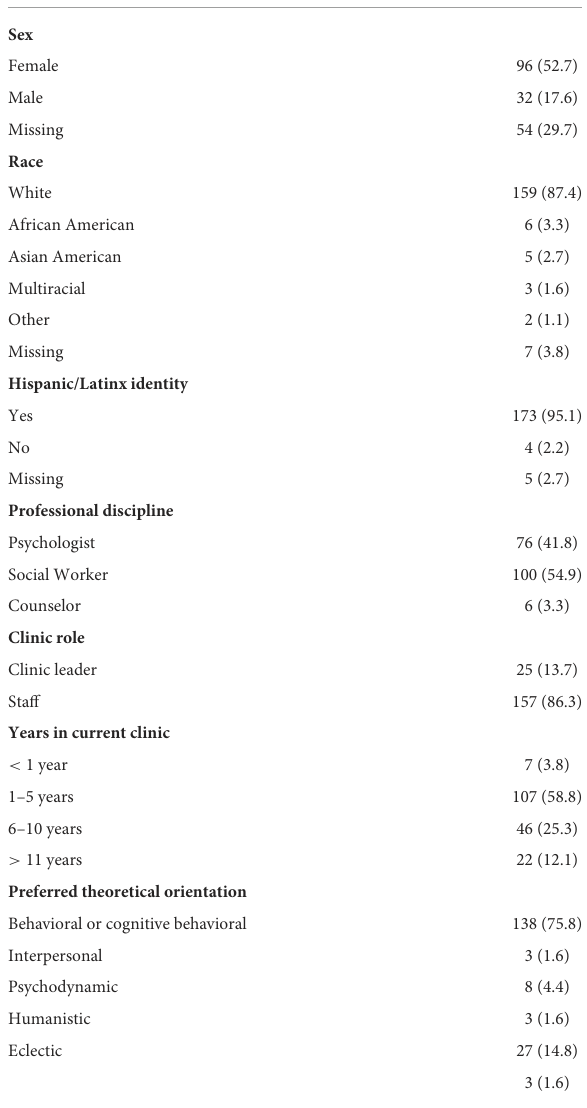
TABLE 2 Characteristics CPT and PE therapists ( n =